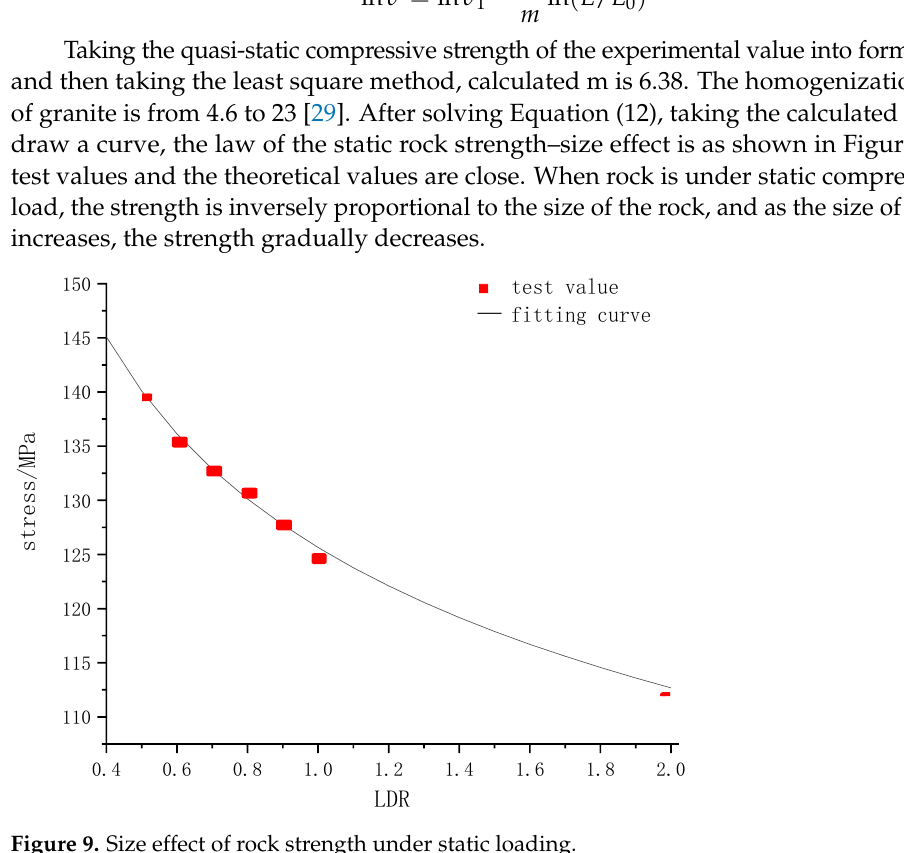
Figure 9. Size effect of rock strength under static loading.